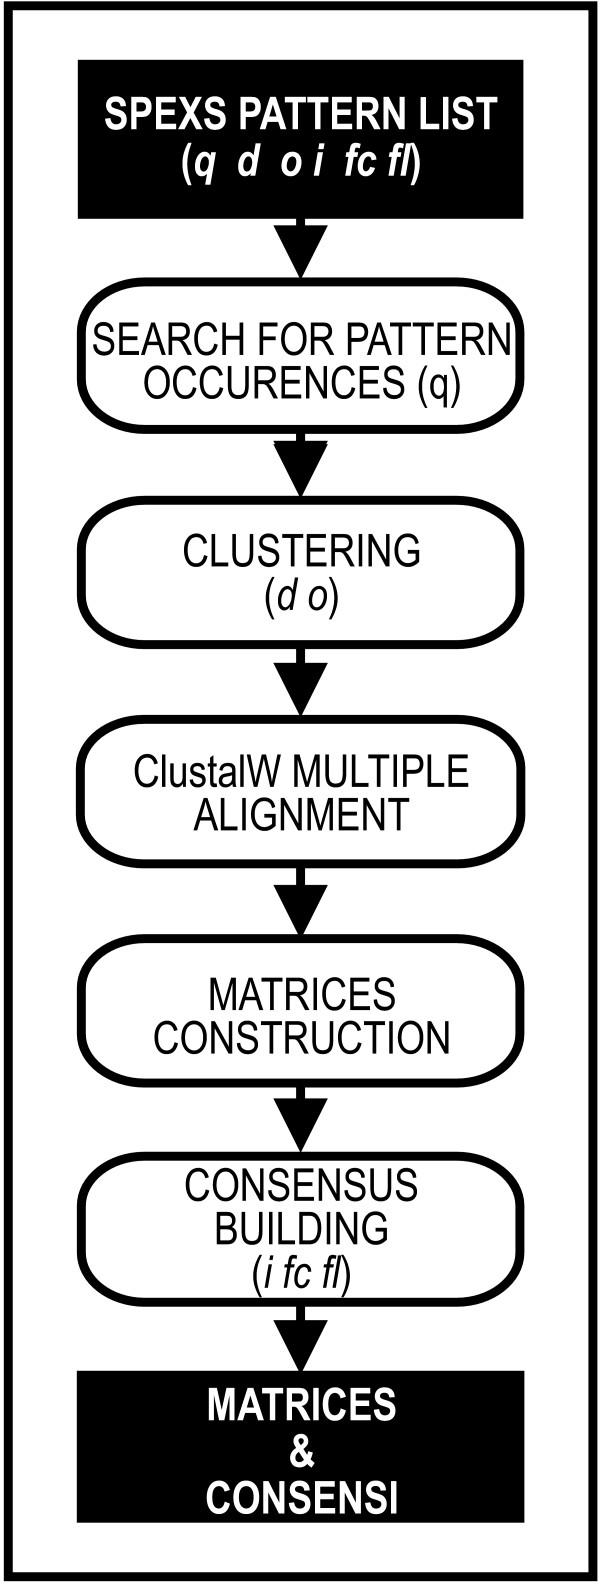
Flow-chart of COOP program. Input, output and main steps are shown.